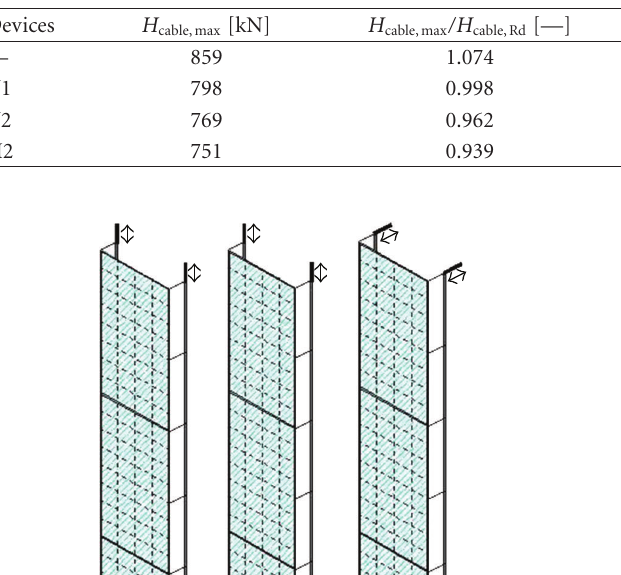
Table 3: Results of incremental analyses (ABAQUS). Cable axial forces, sliding of devices. M02 FE-model, BL1.